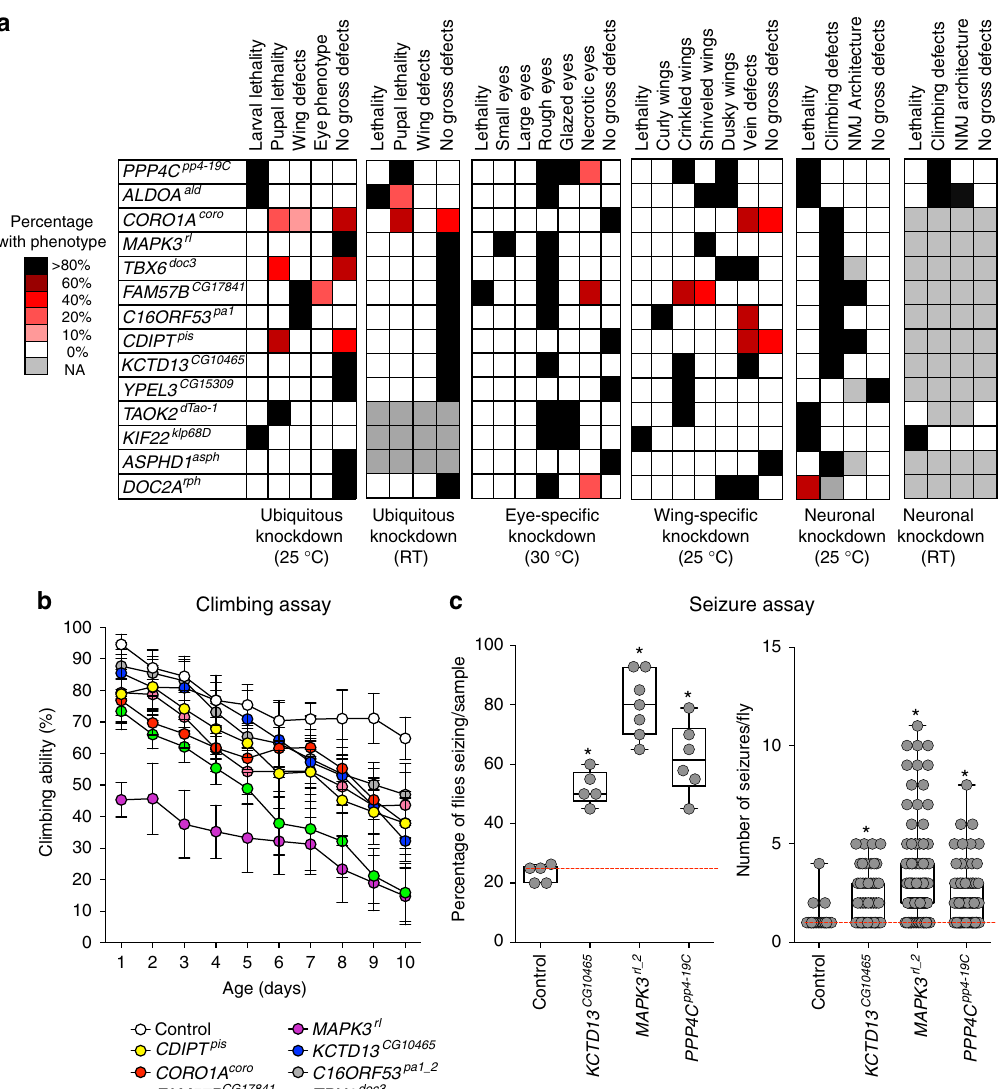
Fig. 2 Neurodevelopmental defects in fl ies with knockdown of individual 16p11.2 homologs. a Percentage of 16p11.2 homologs with ubiquitous, eye-speci fi c, wing-speci fi c, and pan-neuronal knockdown at various temperatures that manifest speci fi c phenotypes. b Assessment of 16p11.2 homologs for motor defects showed changes in climbing ability over ten days (two-way ANOVA, p = 0.028, df = 62, F = 1.61). Data represented here shows mean ± standard deviation of 10 independent groups of 10 fl ies for each line. c Assessment of knockdown of 16p11.2 homologs for frequency of spontaneous